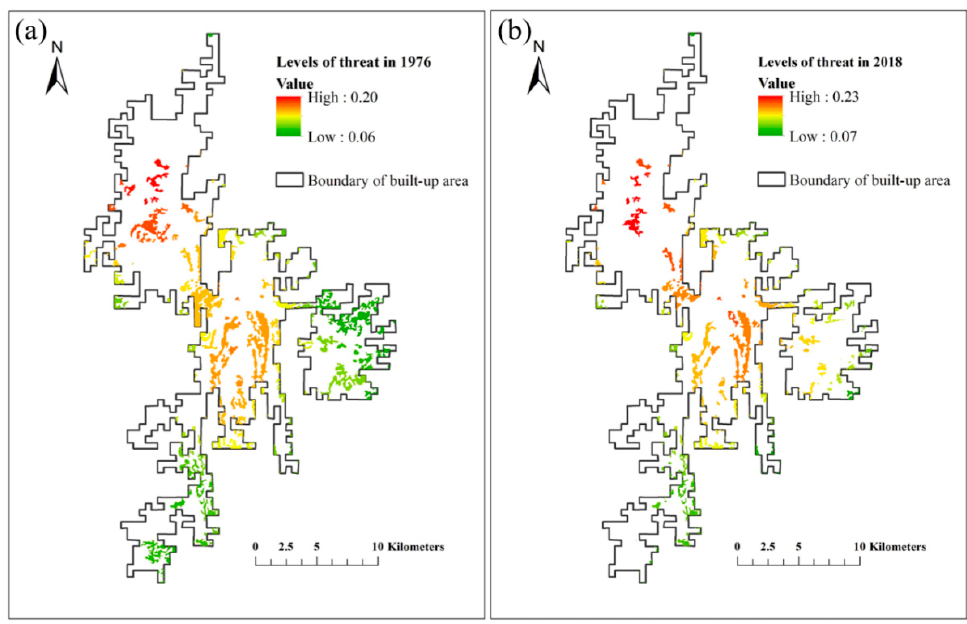
Figure 8. Levels of threat to historical forest patches in ( a ) 1976 and ( b ) 2018.